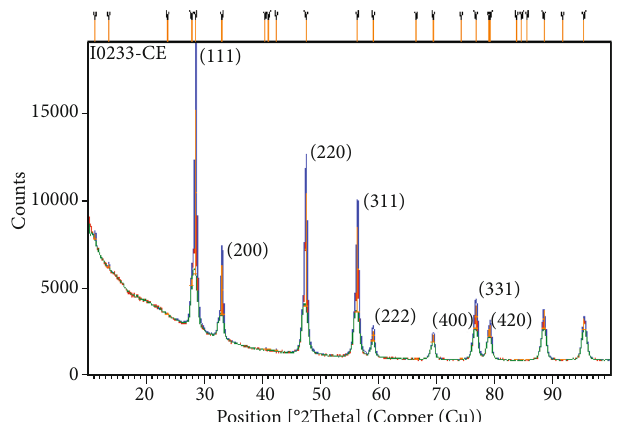
Figure 4: XRD of CeO